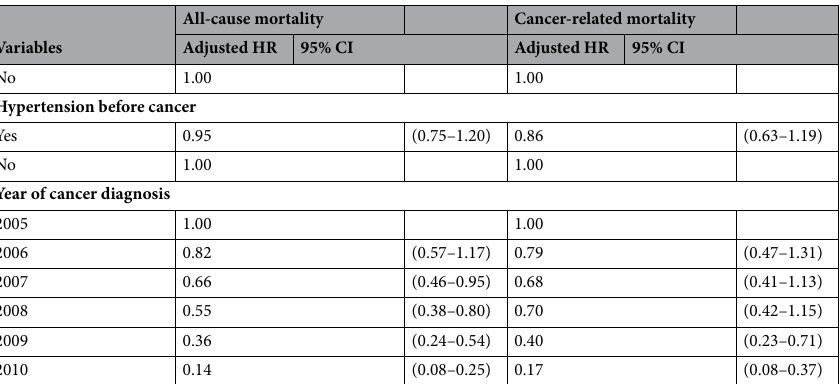
Table 2. Association between health behavior changes and mortality among cancer survivors. a Body mass index.